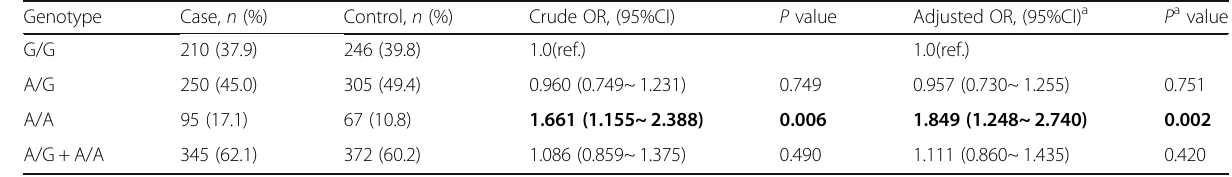
Table 3 H19 polymorphisms (rs217727) among the cases and controls and the associations with risk of LC Genotype